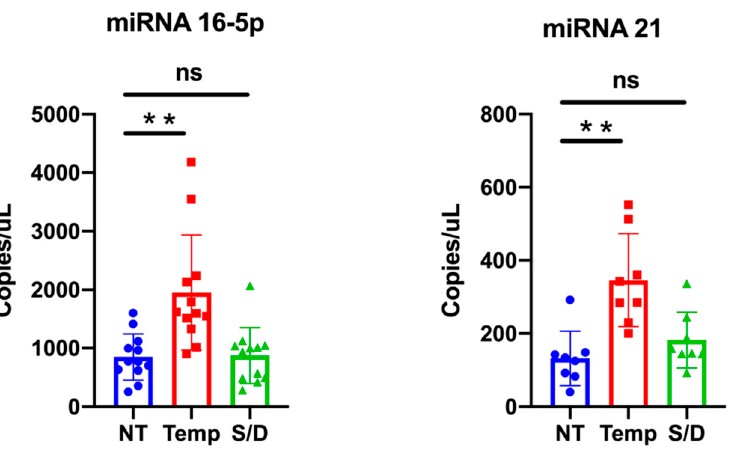
Figure 6. miR-16-5p and miR-21-5p expression levels in untreated (NT), heat treated (HT) and solvent/detergent (S/D)-treated healthy sera analyzed by droplet digital PCR. Significance level: p < 0.05; ** = p < 0.01.